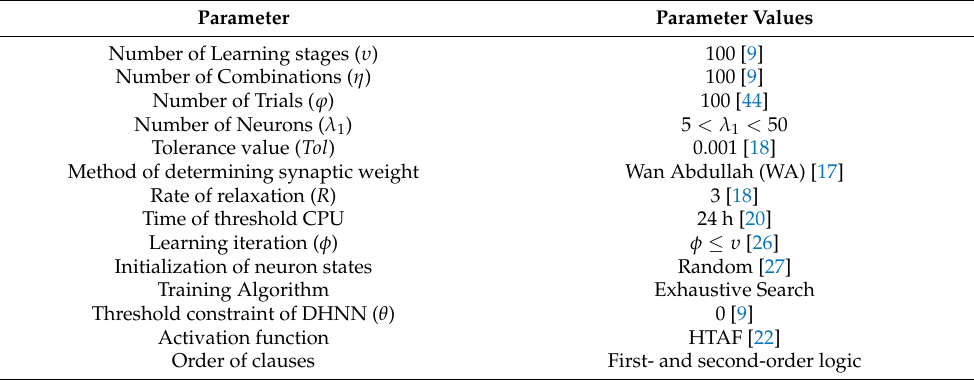
Table 3. List of parameters for DHNN − δ 2 SAT